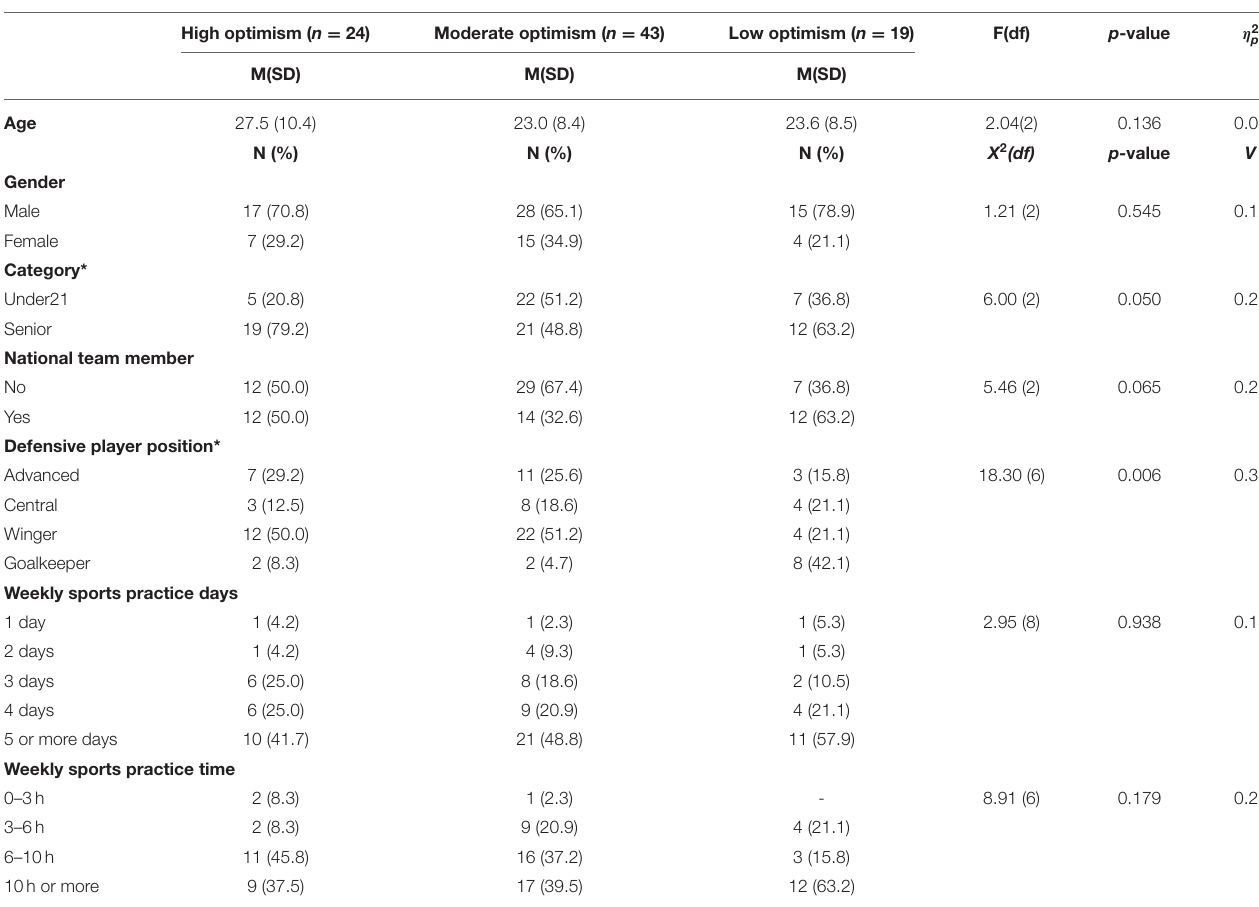
TABLE 4 | Characteristics of the different cluster groups. High optimism ( n = 24) Moderate optimism ( n =